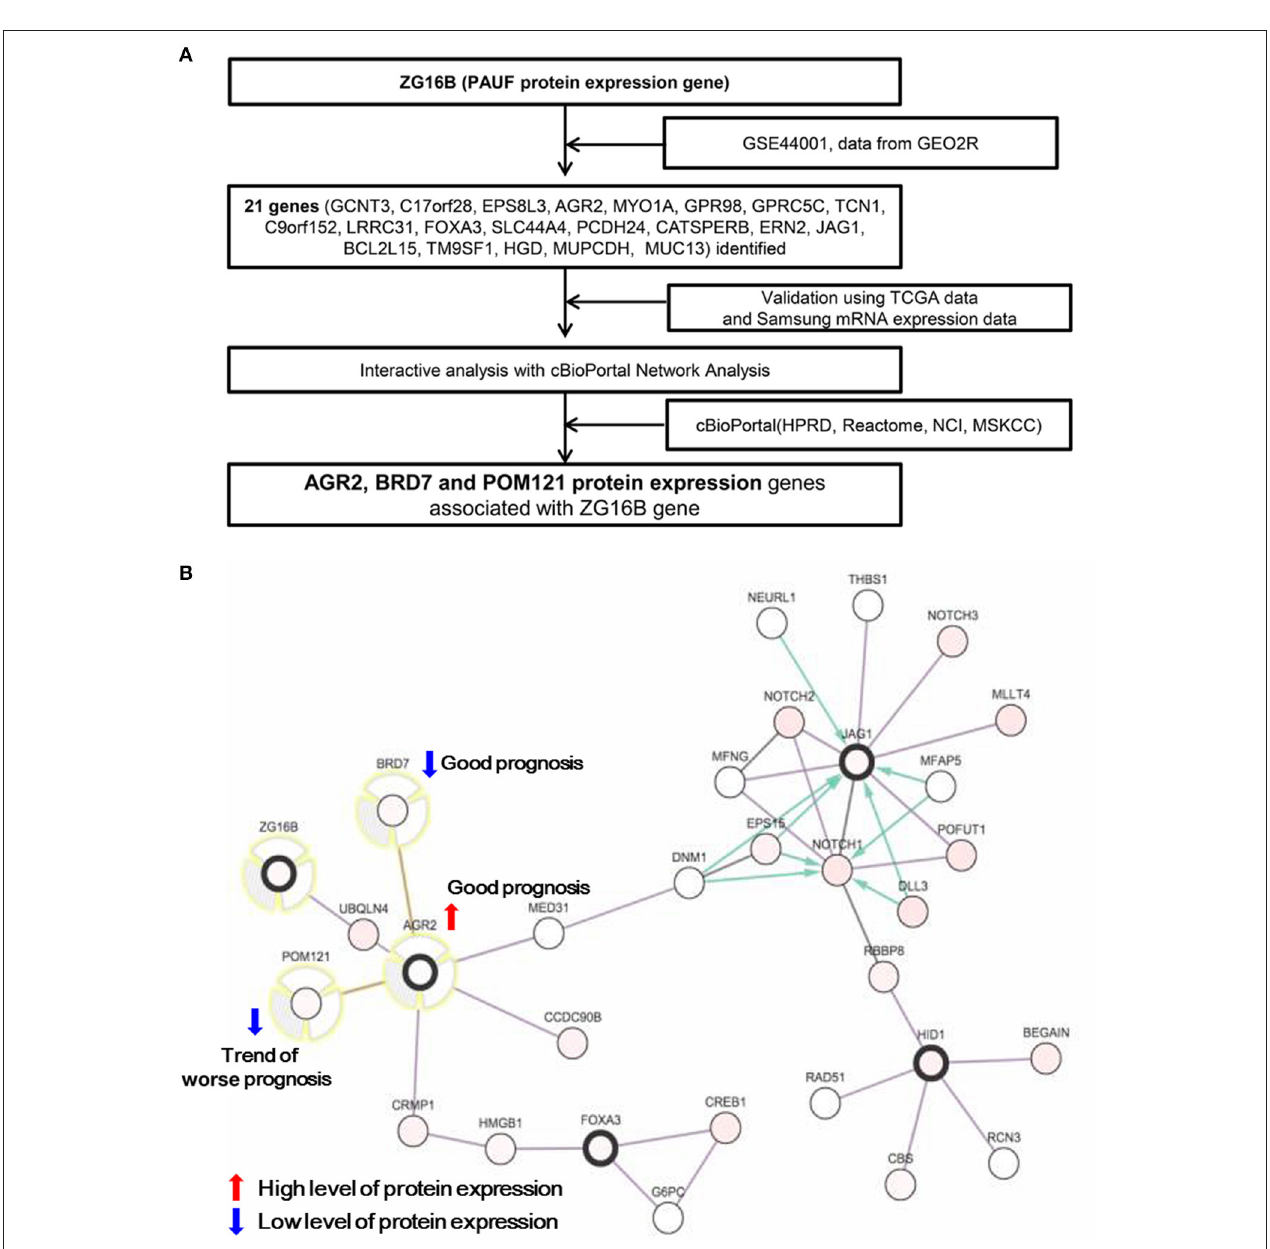
FIGURE 1 | (A) Flow chart identifying the candidate PAUF-associated prognostic markers. (B) Network view of 22 genes using interactive analysis with cBioPortal network analysis (http://cbioportal.org). Among candidate genes, high expression of AGR2 protein and low expression of BRD7 protein are significantly associated with favorable disease-free survival while the low expression of POM121 protein shows a trend of worse prognosis in patients with cervical